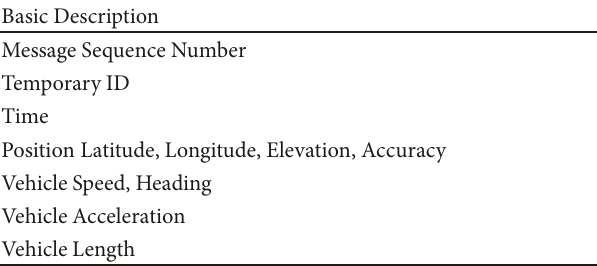
Table 1: Basic information for